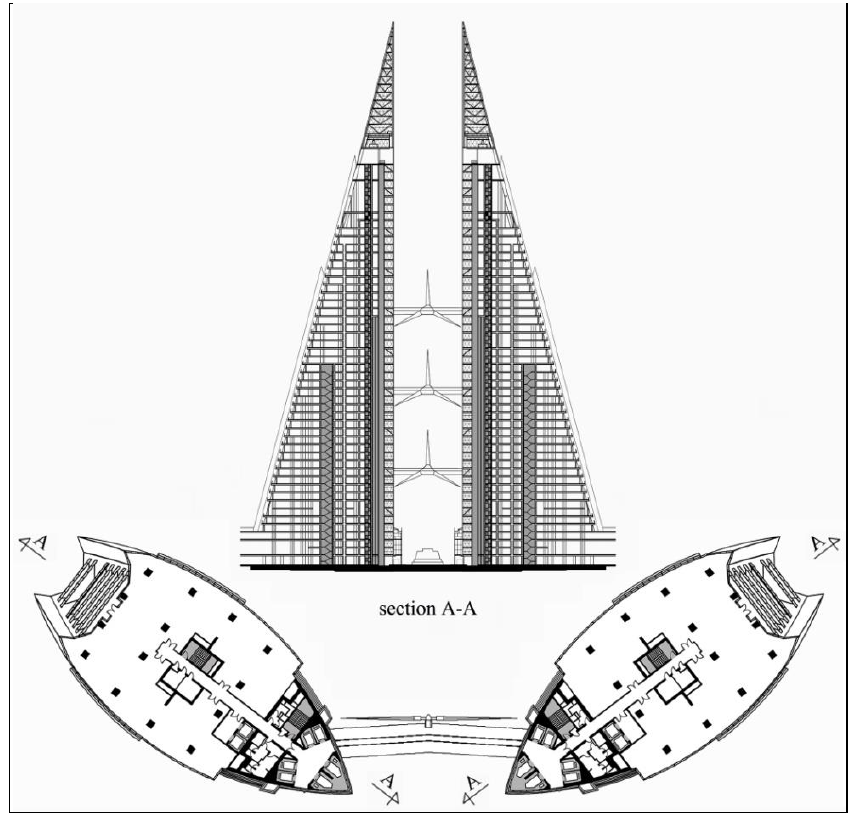
Figure 25. Bahrain World Trade Center: Floor plan and section (developed by authors on the basis of [54]). Buildings 2019 , 9 , x FOR PEER REVIEW